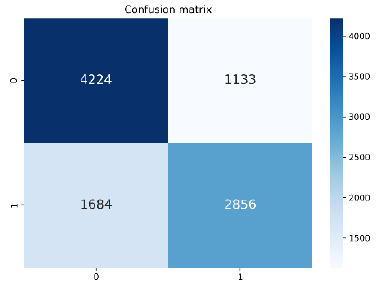
Figure 4. Confusion matrix for